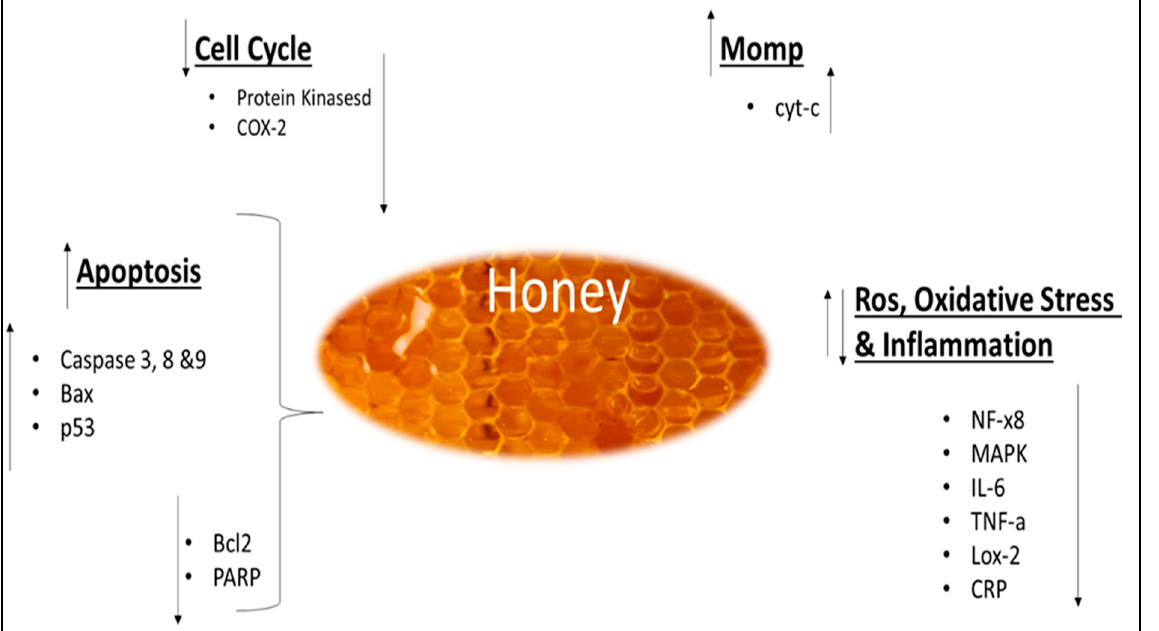
Figure 3. Molecular mechanism involved in anticancer effect of honey. Adapted from Cianciosi et al. (2018) [18] and Mohd et al. (2021)[29]. Table 5. List of anticancer properties of MH, TH, KH, and SH.